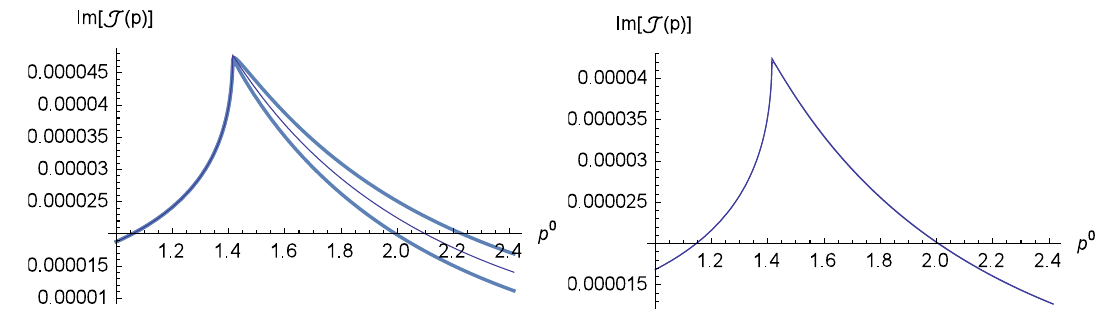
Figure 14 . Comparison between our formulation and the CLOP